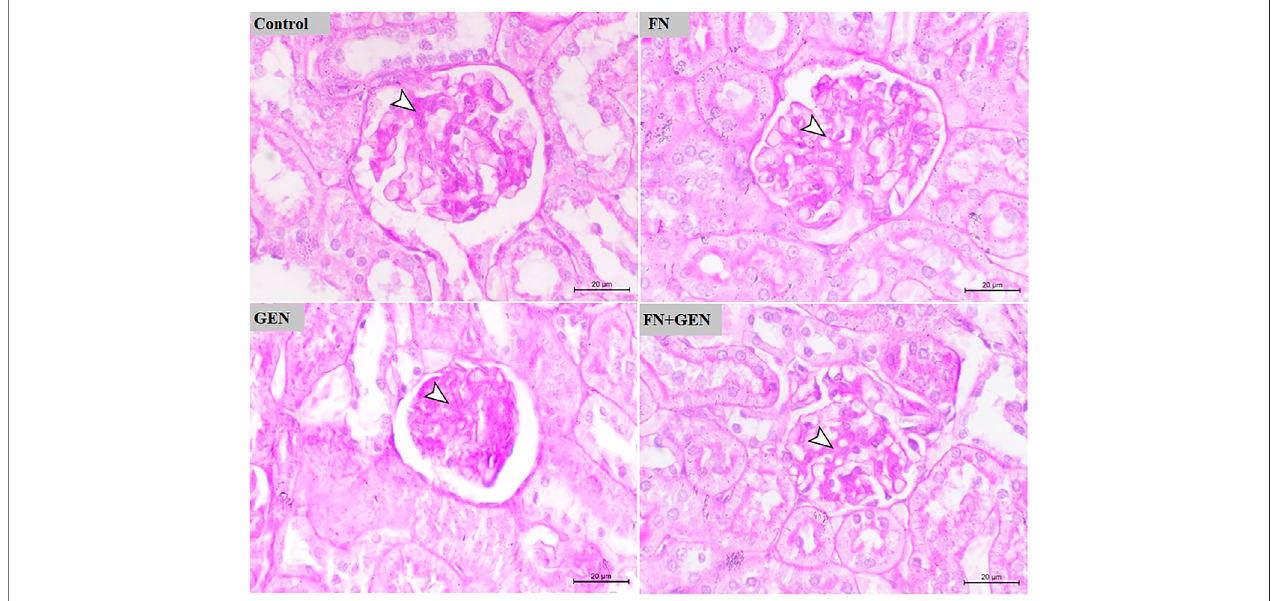
FIGURE 3 | FN prevents GEN-induced histopathological damage in the kidney. Photomicrographs of renal sections of control rats and FN-treated rats demonstrating normal renal histology with very fi ne mucopolysaccharides on the glomerular tuft. GEN-administered rats showing glomerular atrophy associated with markeddeposition ofmucopolysaccharideson theglomerulartuft.GEN-administered ratspre-treated withFN showing mild deposition ofmucopolysaccharideson the glomerular tuft (PAS, X400, scale bar = 20 µm). FN: formononetin; GEN: gentamicin; and PAS: periodic acid – Schiff.